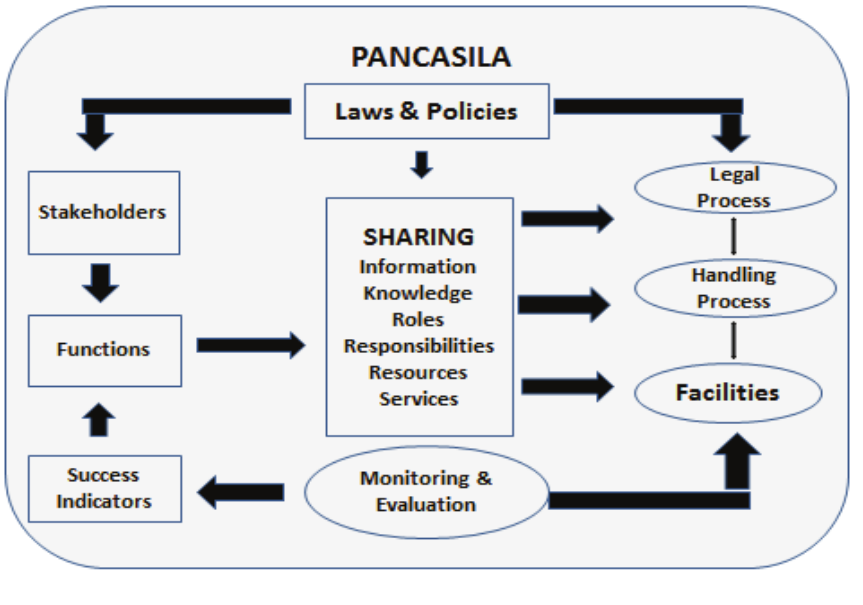
figure 6: the proposed Integrative-progressive